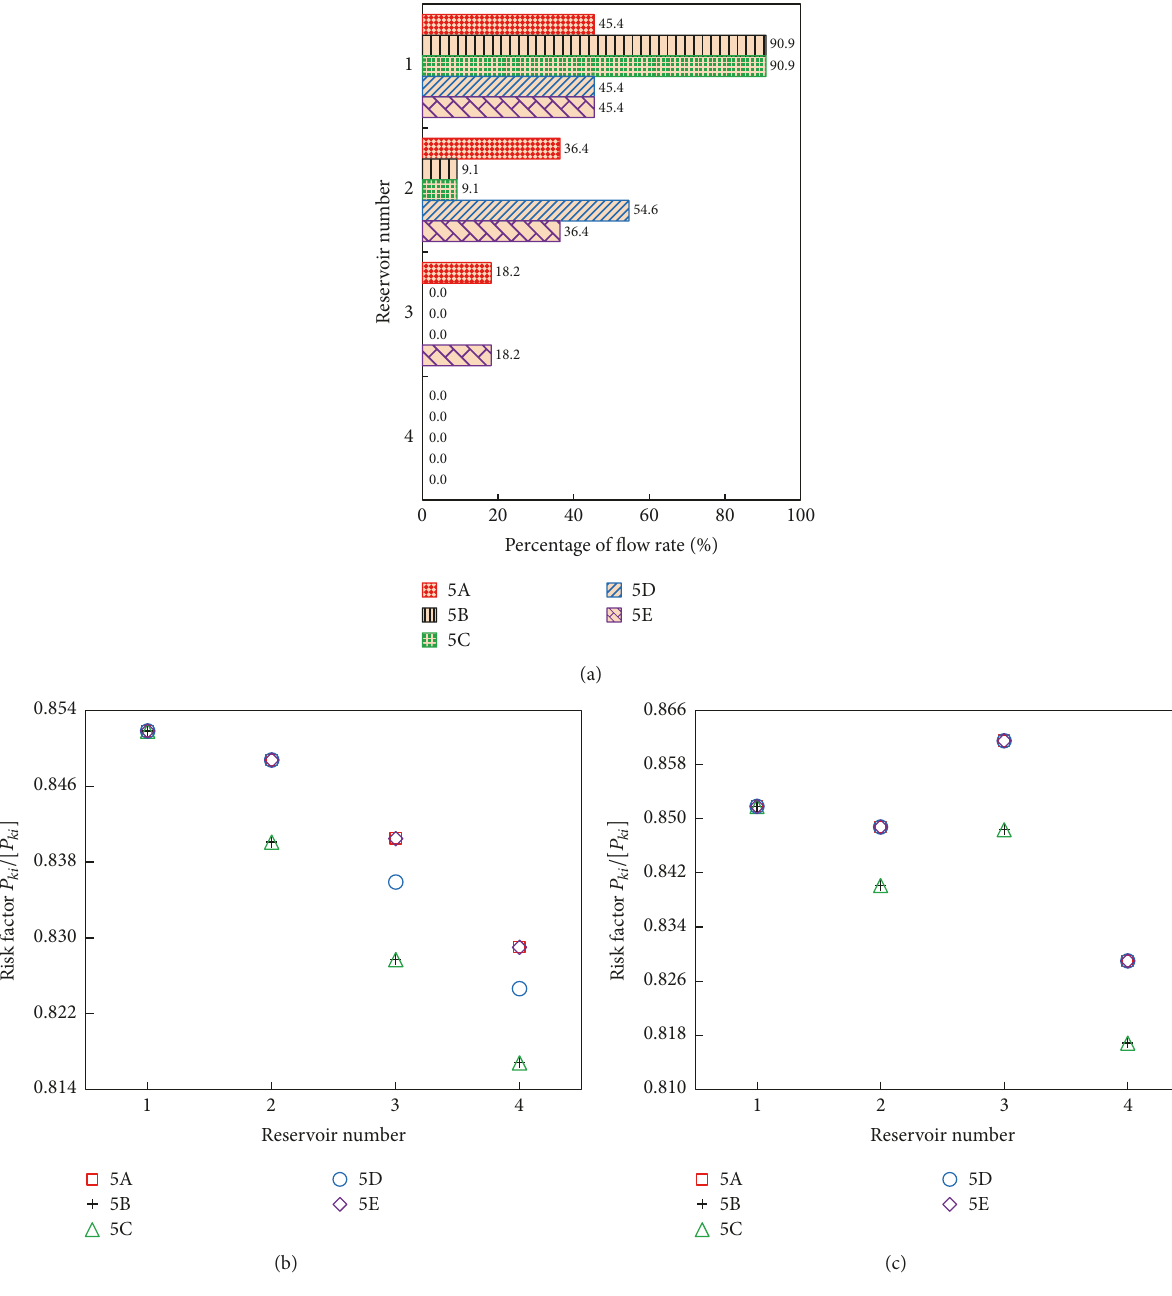
Figure 9: Proportions of the inflows (a) and risk factors of each reservoir for different reservoir permeabilities for the two scenarios of the conceptual engineering model. (b) and (c) are the risk-factor results for Scenarios S-1 and S-2,